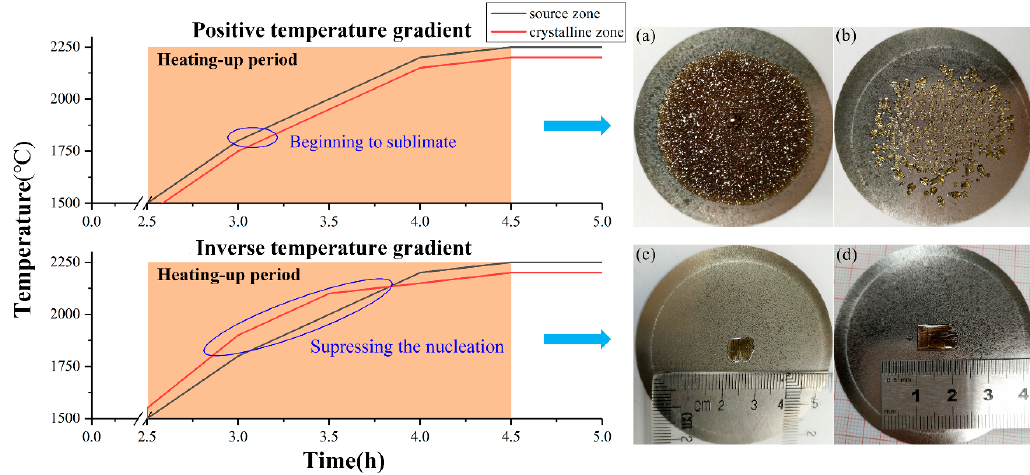
Figure 3. The temperature control process of heating with a positive temperature gradient ( ∆ T > 0) and an inverse temperature gradient ( ∆ T < 0). Images ( a , b ) and ( c , d ) on the right side respectively show the crystallization of AlN without and with inverse temperature-gradient method.